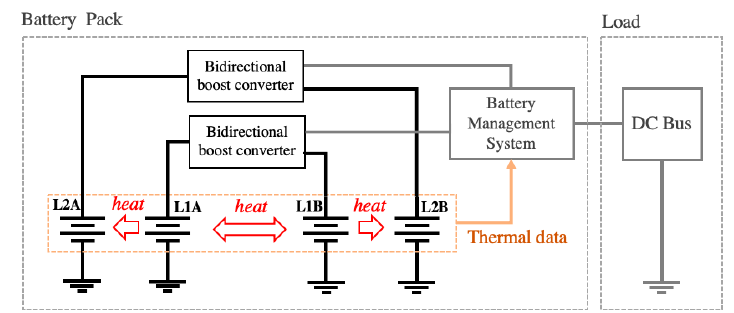
Figure 4. Electrical model with heat transfer between the groups and layers in a battery pack.